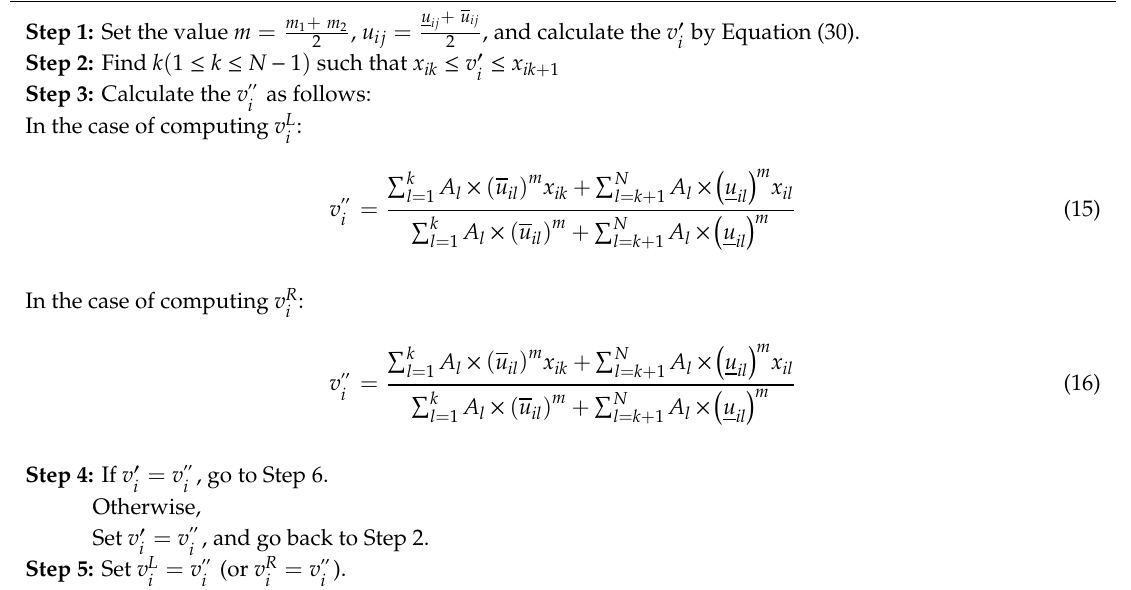
, u ij , m 1 , m 2 , A ij